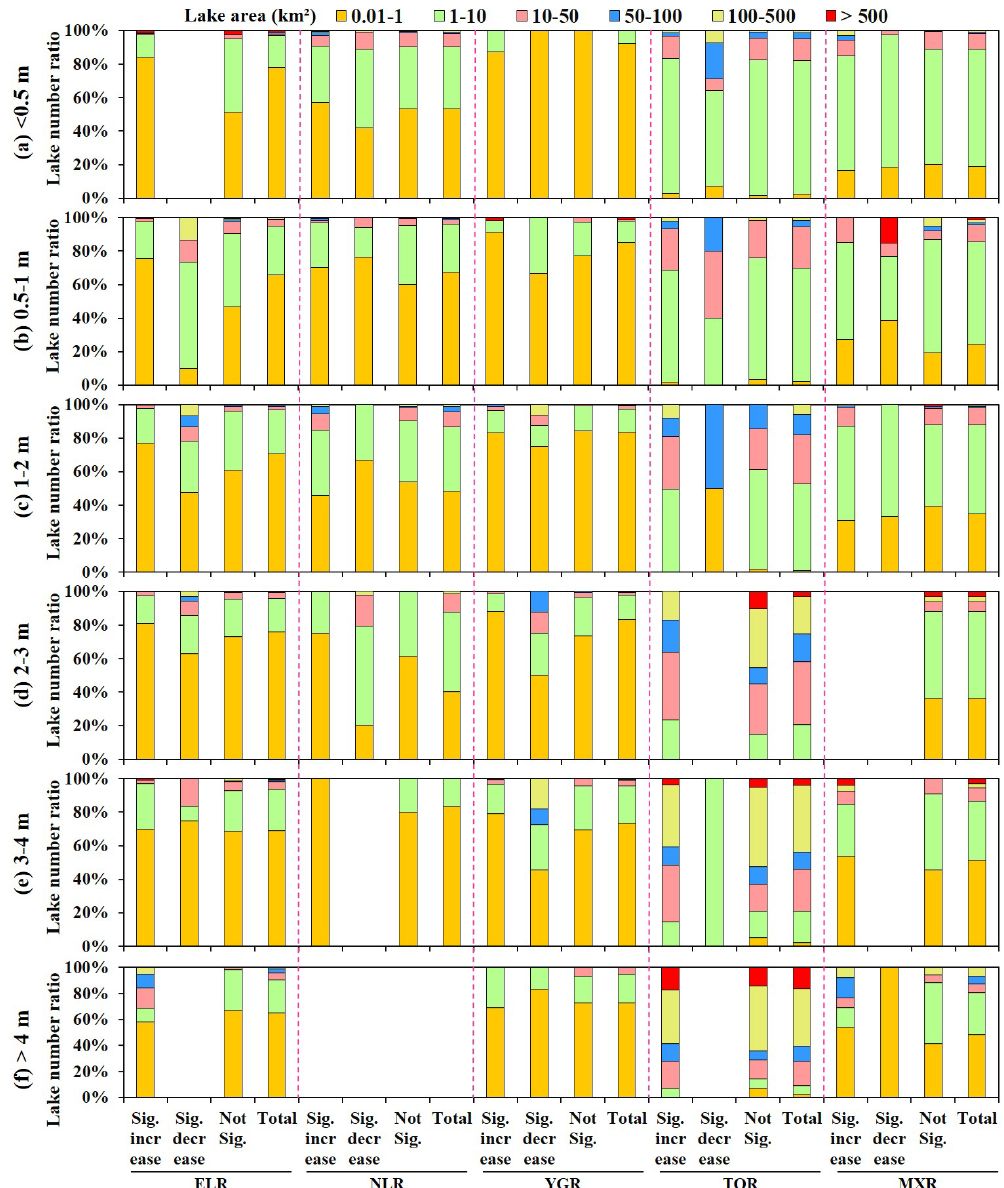
Figure 6. Proportions of lake numbers in different areas in the six SDD categories. The six SDD categories are (a) < 0 . 5m, (b) 0.5–1m, (c) 1–2m, (d) 2–3m, (e) 3–4m and (f) > 4m. The SDD values are the average of estimated results in each lake during 1984–2018. In the five lake regions, the lakes are further divided into three types – lakes with SDD showing significant increasing (Type I), significant decreasing (Type II) and non-significant (Type III) trends during